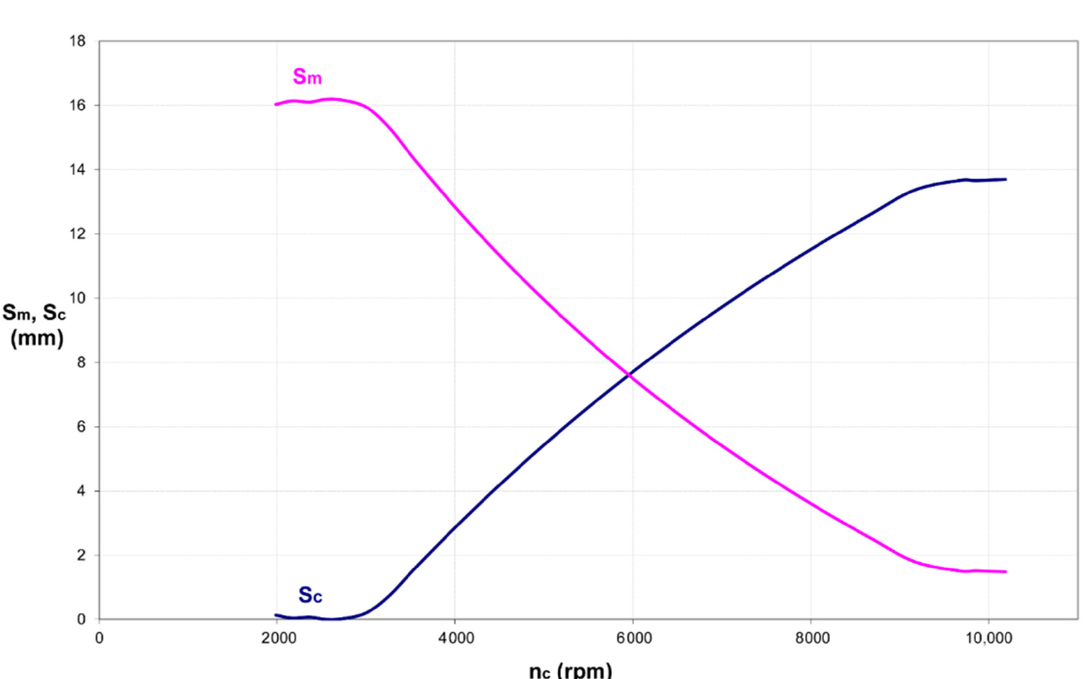
Figure 10. Typical movable half-pulleys axial displacement trend ( S c -driven one and S m driver one). In this way, the instantaneous transmission geometry is described for each driver pulley rotation